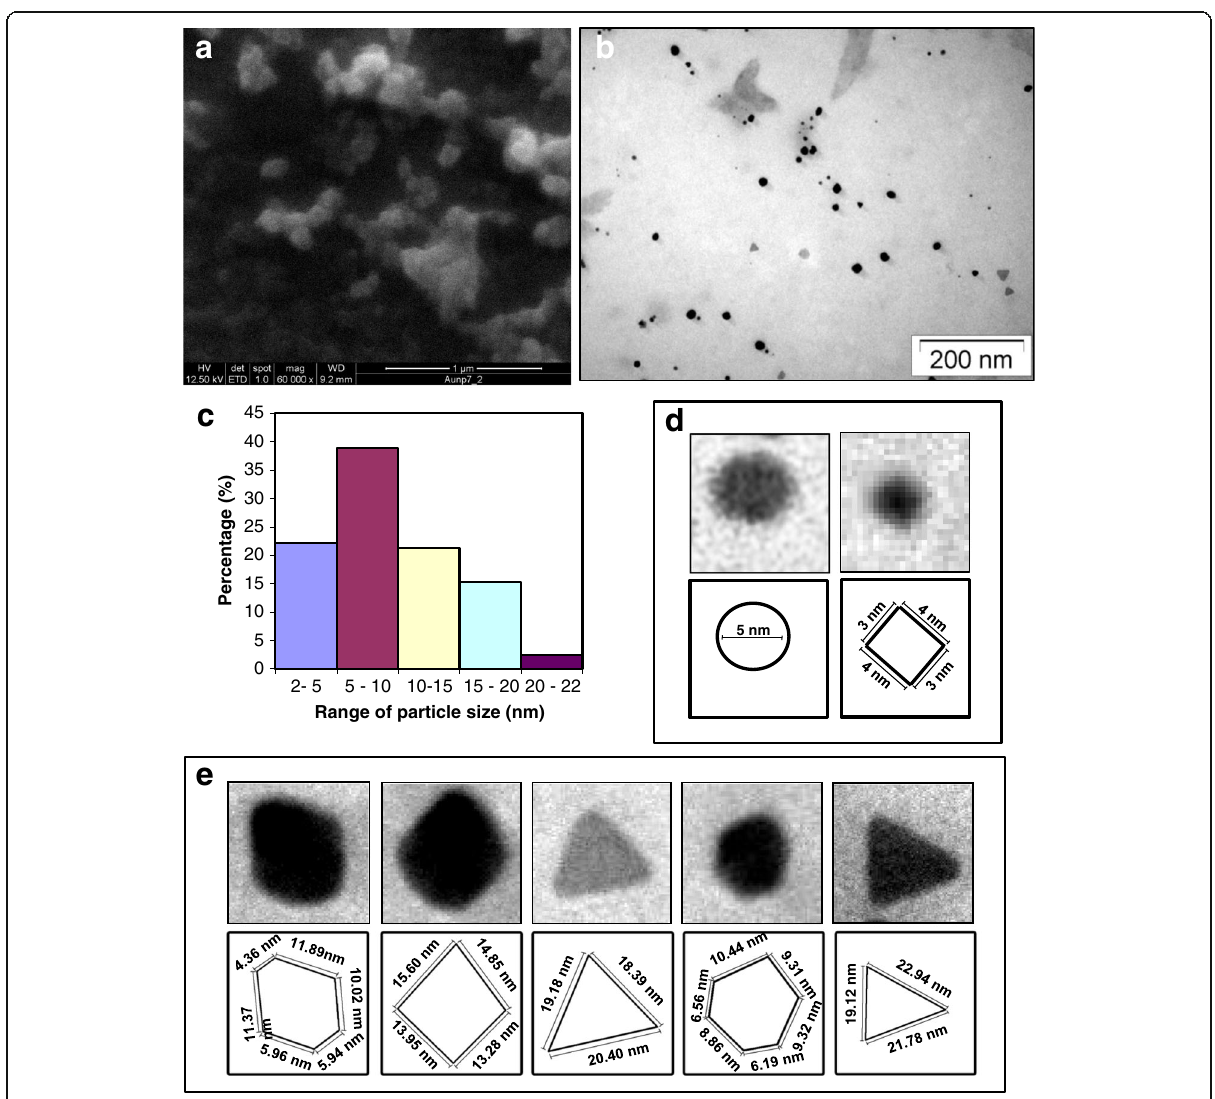
Fig. 4 Electron microscopy of the AuNPs. a SEM at magnification of × 80,000. b TEM showing dispersed particles of different sizes in a microscopic field. c A histogram showing particle size distribution of the AuNPs. Enlarged view of individual AuNPs showing different geometric shapes and their diagrammatic representations with dimensions. d Spherical (left) and rhomboidal (right) of small size range. e From left: hexagonal, equilateral triangular, rhomboidal, polyhedral, and isosceles